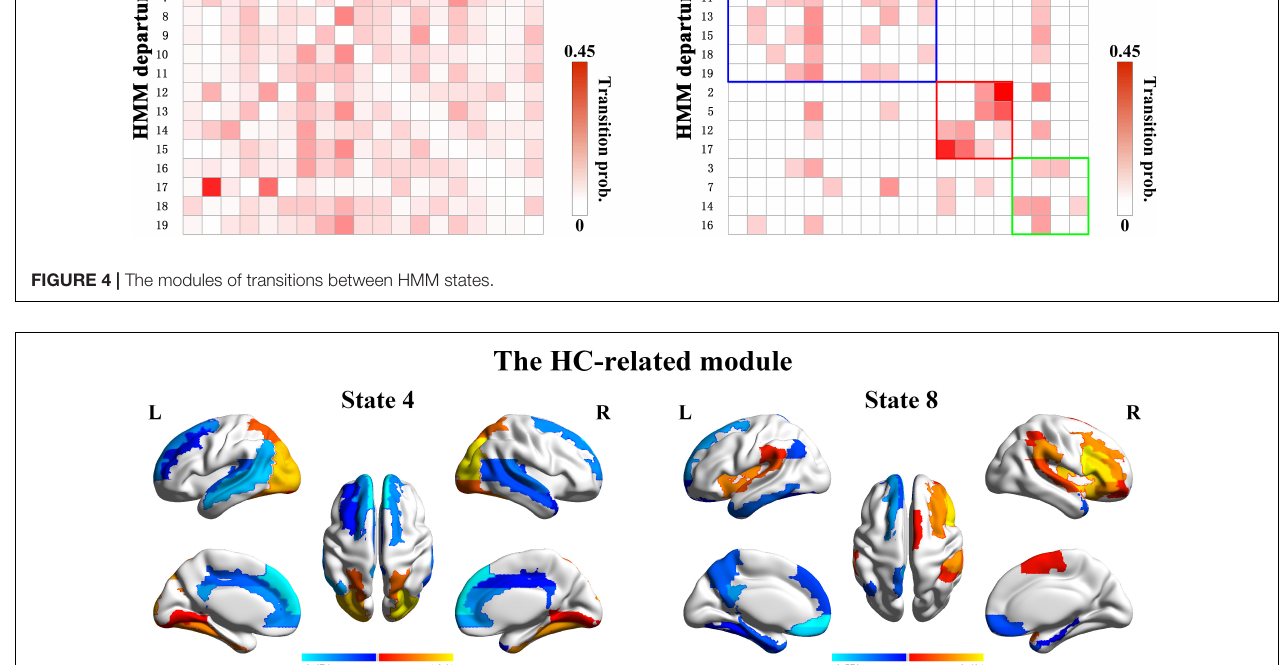
superior frontal gyrus, the bilateral anterior and PCC and the bilateral rectus). The HMM state 10 was mainly characterized by decreased activation in the bilateral thalamus, precuneus, PCC, calcarine lingual gyrus, and superior temporal gyrus and by increased activation in the bilateral superior and medial temporal and inferior orbitofrontal gyrus. Then we found the ASD-related module included two partitions. One was mainly characterized by the HMM state 2 and 17 (the ASD-related module I) and another by the HMM 3 and 14 (the ASD-related module